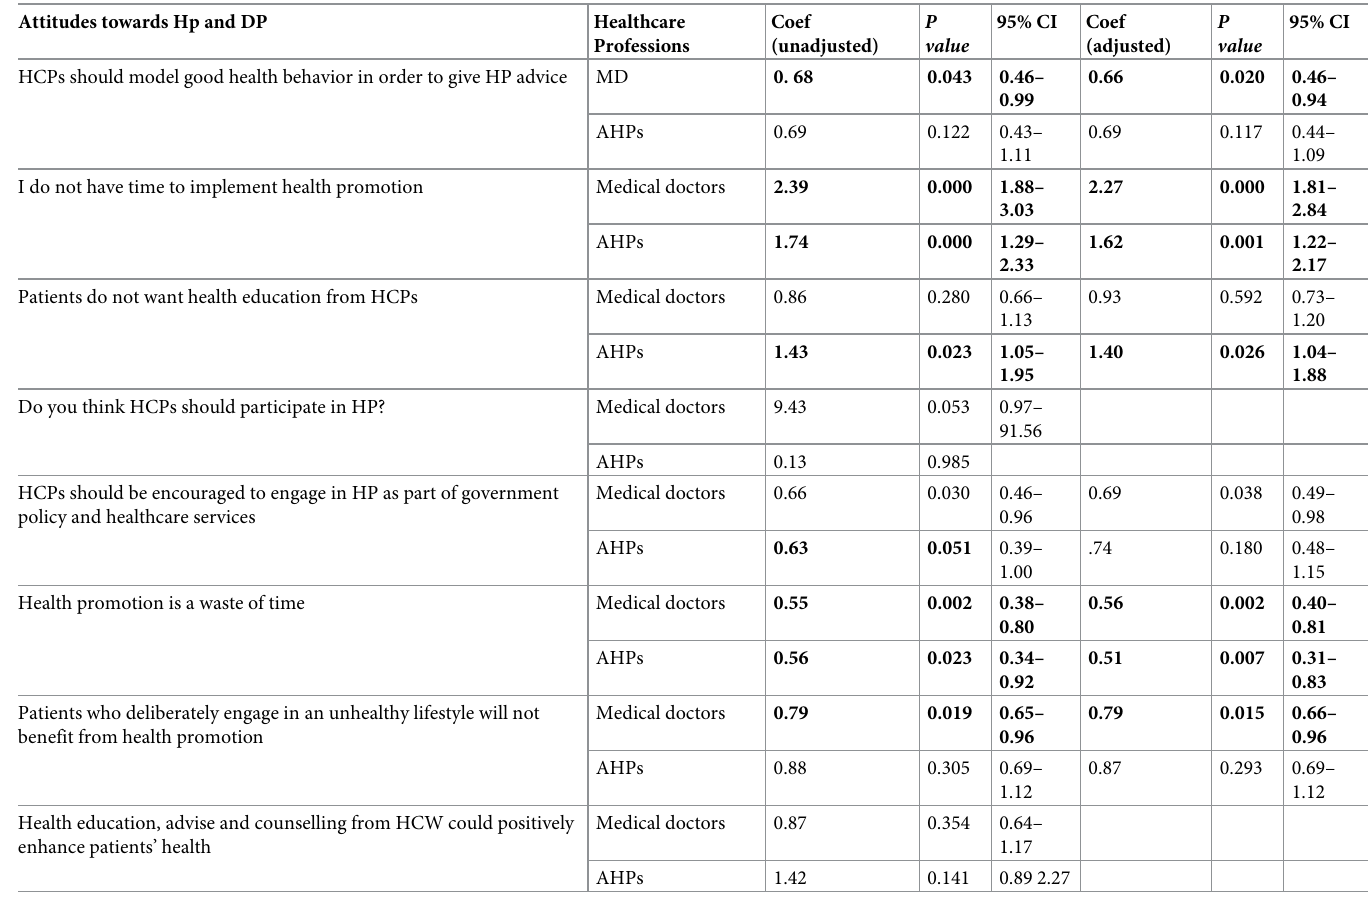
Table 5. Multivariate analysis of attitudes towards health